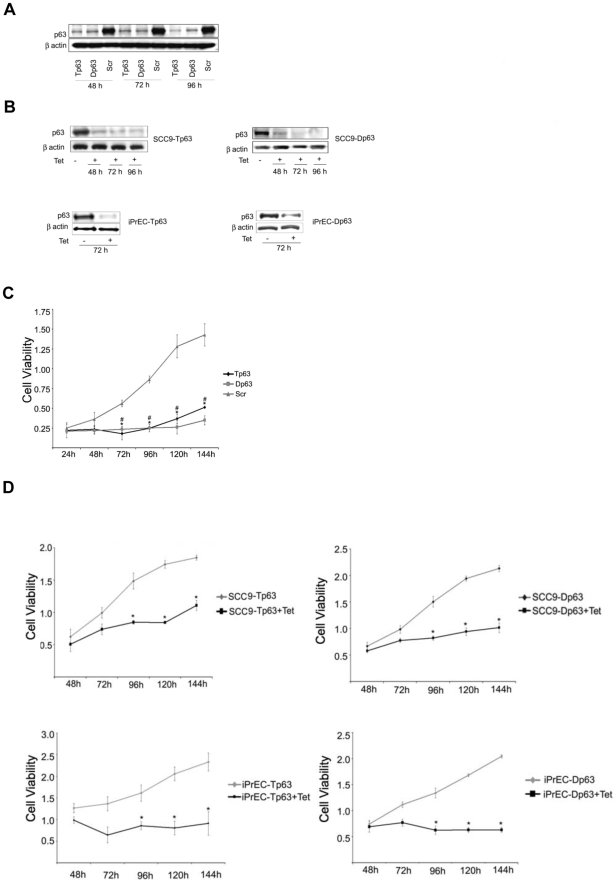
Silencing of either Total or ΔN specific p63 isoforms causes a decrease in cell viability.A. Immunoblot analysis of p63 in SCC9 cells transfected with Tp63, Dp63 or Scr siRNAs. B. Immunoblot analysis of p63 in tetracycline-inducible clones of SCC9 (SCC9-Tp63, SCC9-Dp63), and iPrEC (iPrEC-Tp63 and iPrEC-Dp63) with or without treatment with tetracycline. C–D. Cell viability curves. Quantification of cell viability measured by MTT assay in SCC9 cells transfected with Tp63, Dp63 or Scr siRNAs (C), in SCC9-Tp63 and SCC9-Dp63 cells with or without treatment with tetracycline (D, upper panel) and in iPrEC-Tp63 and iPrEC-Dp63 cells with or without treatment with tetracycline (D, lower panel). Data are shown as means +/− standard error and are representative of three independent experiments.